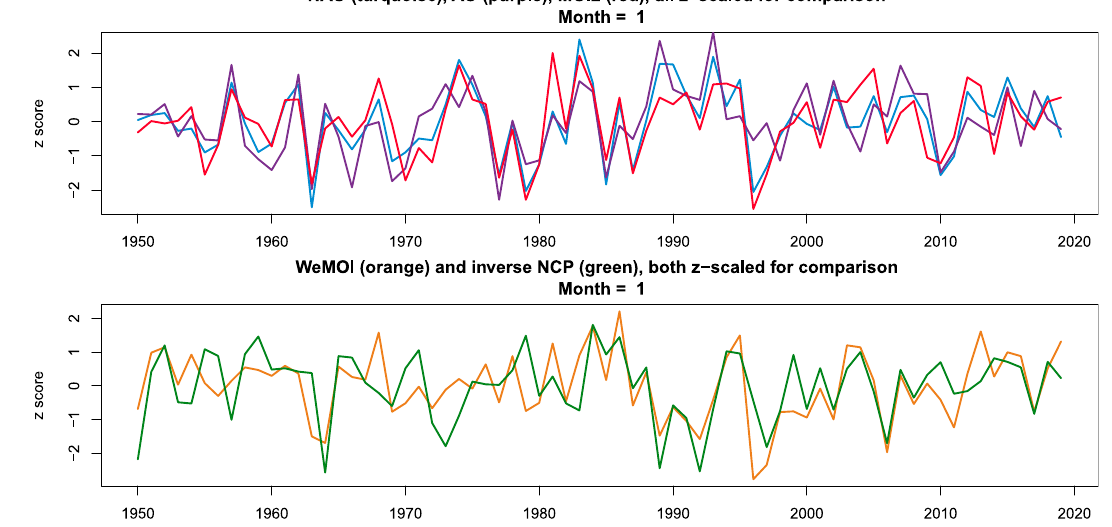
Figure 5. January time series of the five atmospheric indices, clustered according to the r values in Table 1: The upper panel shows the synchronicity of NAO, AO, and MOI2, the lower panel that of WeMOI and NCP.